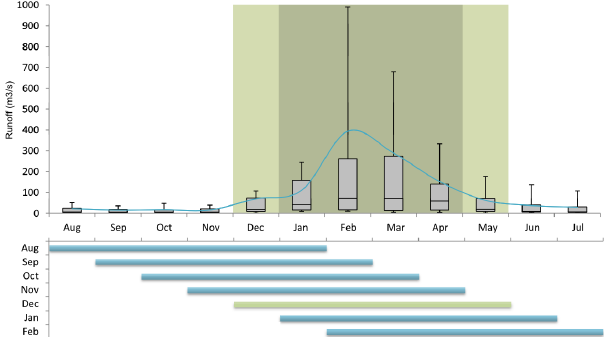
Figure 4. Upper plot: Limpopo River flow regime for Station 24 at Chókwe. The blue line represents the average observed runoff, and the whiskers of the boxplots represent the 10th percentile and the 90th percentile. The lighter and darker shaded areas represent the main runoff period and high runoff period, respectively. Lower plot: initialization dates and length of forecasts during the year. The forecast issued in December is highlighted as the one that captures the main runoff